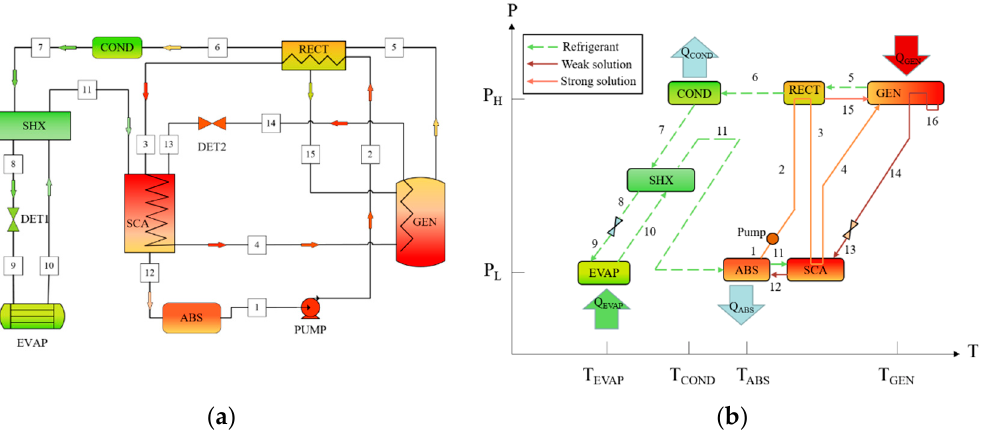
Figure 1. ( a ) Schematic representation of the basic cycle. ( b ) Pressure and temperature levels of the basic cycle.